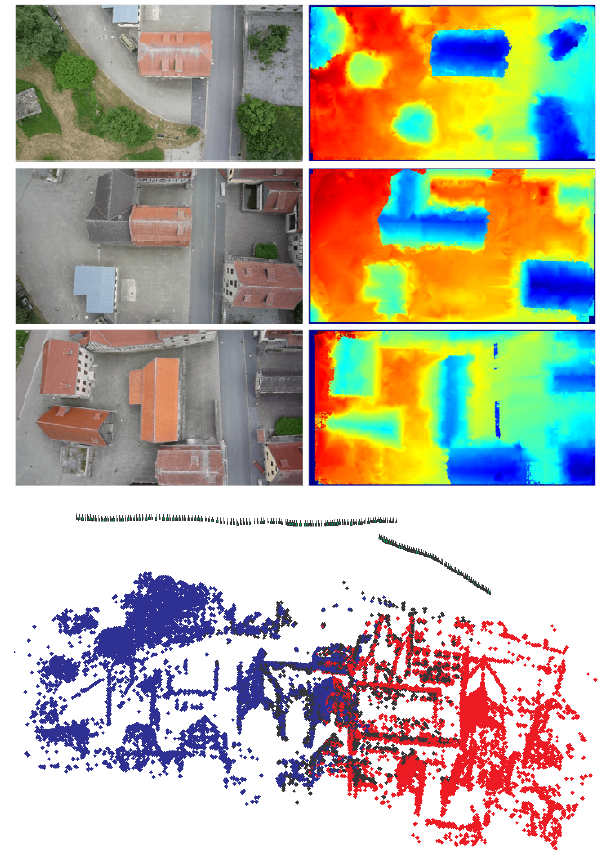
Figure 3: Top: three reference frames and corresponding depth maps obtained as described in Sec. 2.2 and the (intrasensorial) registration procedure of Sec. 2.4. Bottom: the complete camera trajectory and a sparse point cloud obtained as a union of three workspaces (coloured in blue, black and red). From the kink in the camera trajectory, it becomes evident that we are dealing with two different